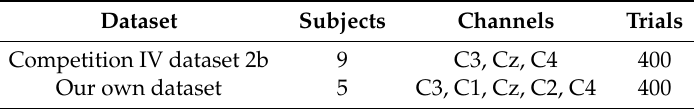
Table 1. Data description for both